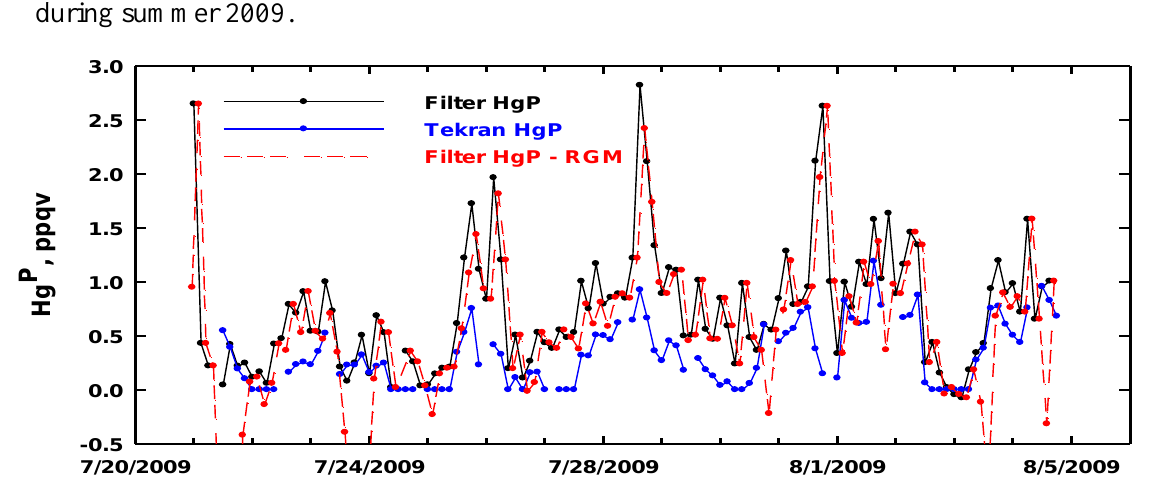
Figure 1. Time series of Tekran and filter measurements of Hg P at Appledore Island during summer